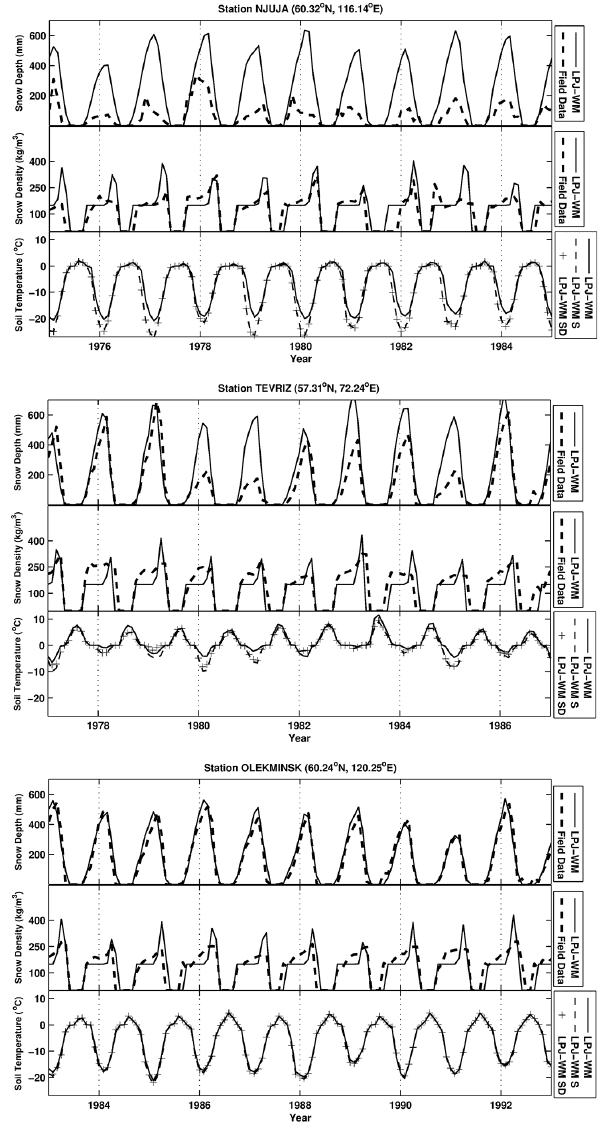
Fig. 5. Comparisons of snow depth (mm) and snow density (kgm − 3 ) acquired from LPJ-WM simulations and field data for three WMO stations located in eastern and central Siberia. The bottom subplot in each figure shows the monthly soil temperature ( ◦ C) at a depth of 25cm produced by LPJ-WM, along with the cor- responding temperature when the model is driven by snow depth alone (LPJ-WM S) and with both snow depth and density (LPJ-WM SD) using values taken from the field records.